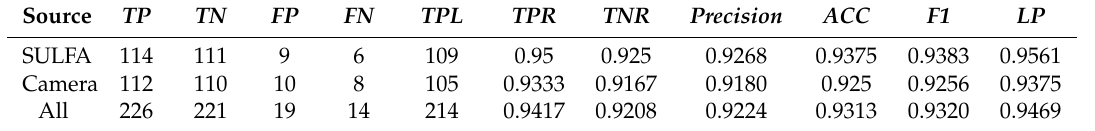
Table 3. Test results of the second dataset.